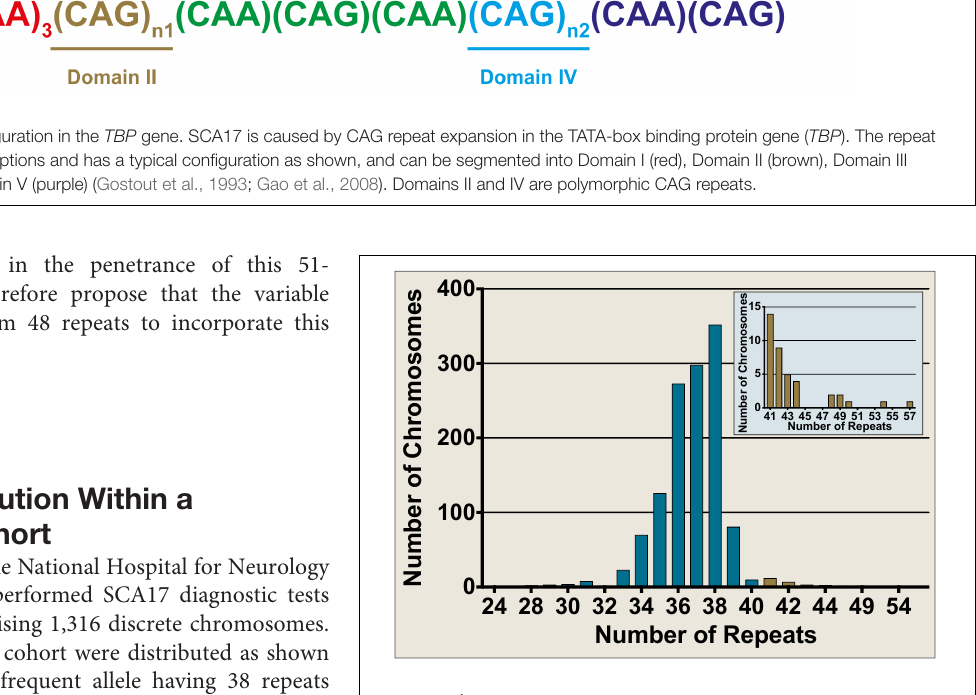
FIGURE 2 | Frequency distribution of SCA17 allele sizes from diagnostic fragment analysis performed on a United Kingdom cohort at the Neurogenetics Unit, National Hospital for Neurology and Neurosurgery, London. SCA17 alleles from 1,316 discrete chromosomes were analyzed by fragment analysis. The main graph shows the frequency of all alleles tested whilst the inset depicts an enlarged view of the alleles in the variable and fully penetrant range (41–57 repeats, n = 39). Normal alleles (24–40 repeats, n = 1277) are plotted in blue, whilst variable and fully penetrant alleles are plotted in brown. The SCA17 alleles ranged from 24 to 57 repeats, with a mean allele size of 37 ± 2 repeats (mean ± standard deviation). The most frequent allele had 38 repeats ( n = 354), whilst the most frequent variable penetrance allele had 41 repeats ( n = 14). Only five alleles were within the fully penetrant pathogenic range ( ≥ 49